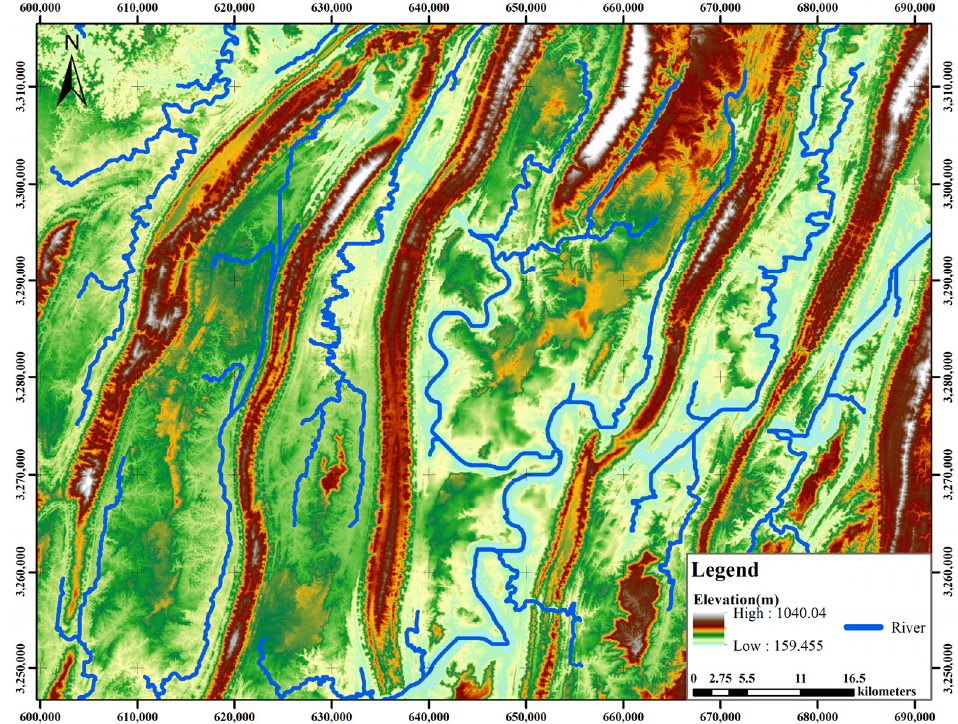
Figure 21. The drainage networks with river flow accumulation >50,000 m 3 in the study region before existing all transverse canyons.